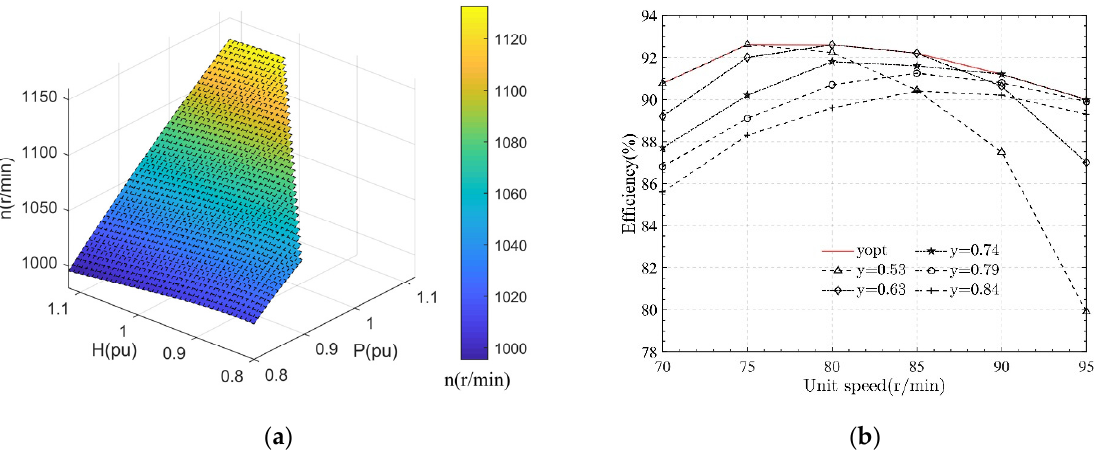
Figure 10. Optimization results in generation mode. ( a ) Optimal speed surface; ( b ) Optimal opening and efficiency.